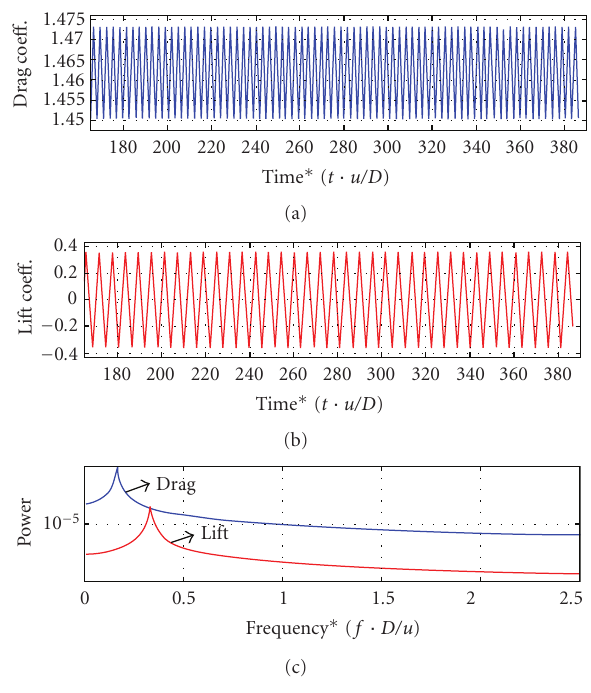
Figure 4: C D and C L time history and their spectrum.